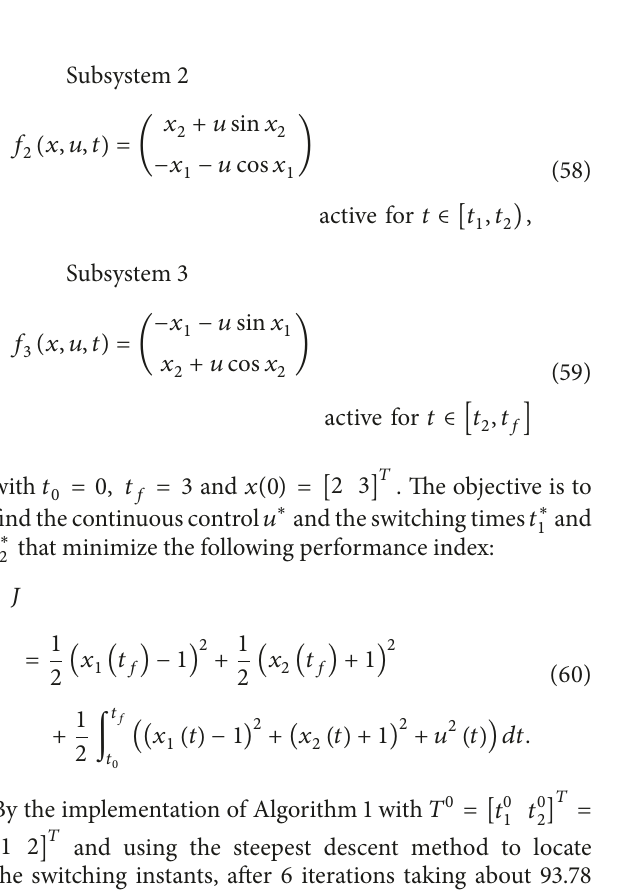
Algorithm 2: Modified Step 2 of Algorithm 1 for solving switched linear quadratic optimal control